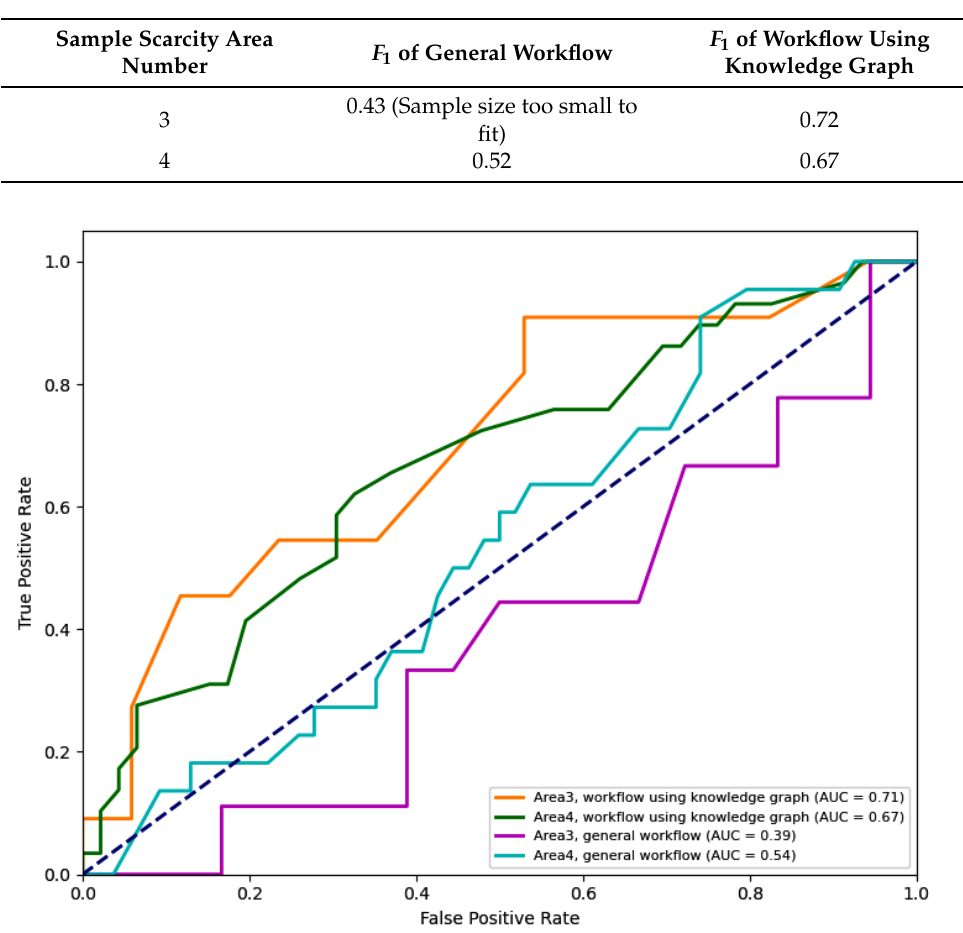
Table 3. Predicted performance of sample scarcity areas.